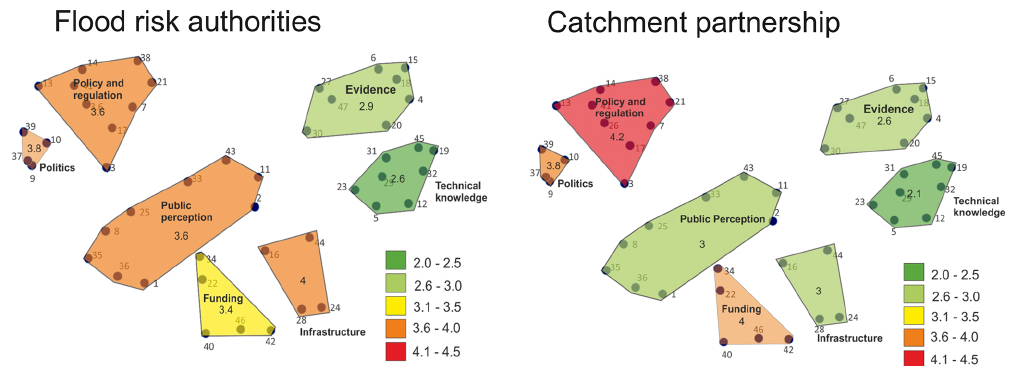
Figure 4. Comparison of flood risk authorities and catchment partnership and the perceived importance of the grouped NFM barrier concepts.